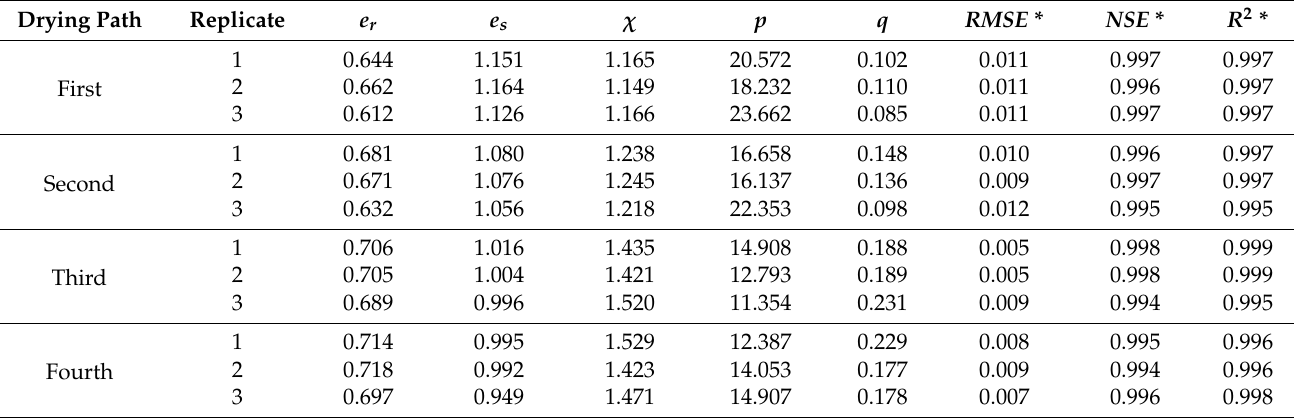
Figure 4. Soil shrinkage curves during four drying paths. Scatters are measured values, and lines were fit using Equation (8). For brevity, only the data of replicate 1 are presented. Table 1. Parameters and goodness of fit of the VG-Peng model for samples during four drying paths.